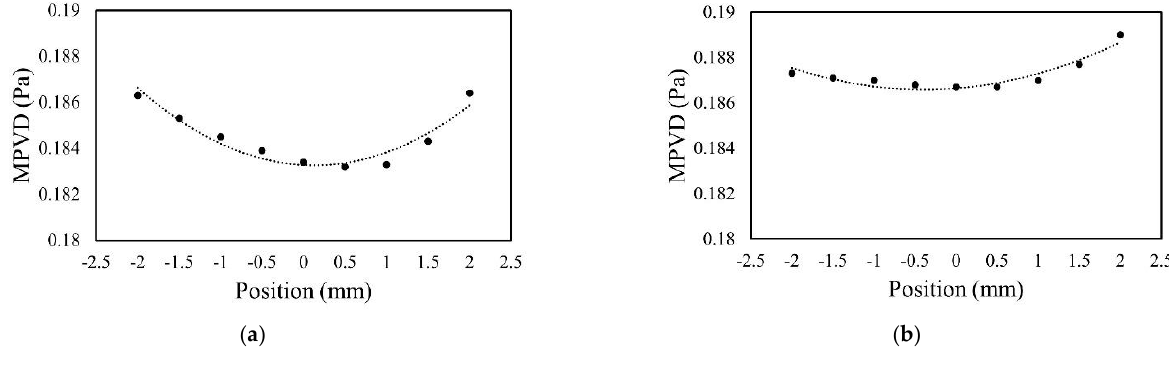
Figure 11. MPVD value at all flake positions in ( a ) Sectors 2 and ( b ) 3.